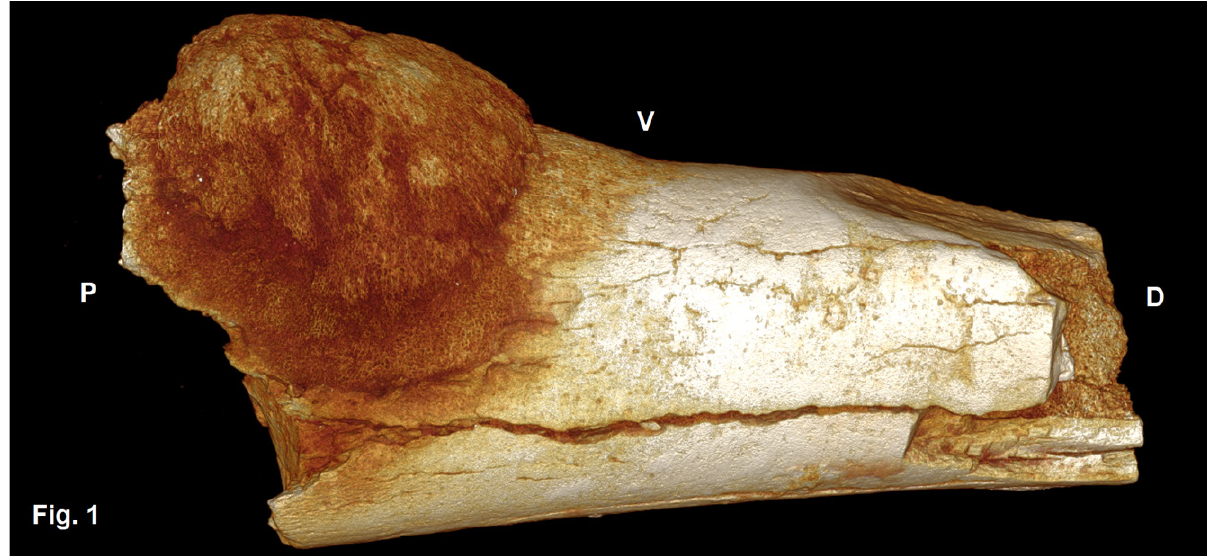
Figure 1: SK 7923 , a hominin 5th metatarsal, exhibits a hemi-spherical bony mass located on the proximo-ventral aspect of the shaft, abutting the cortical bone surface. P – proximal, D – distal, V –